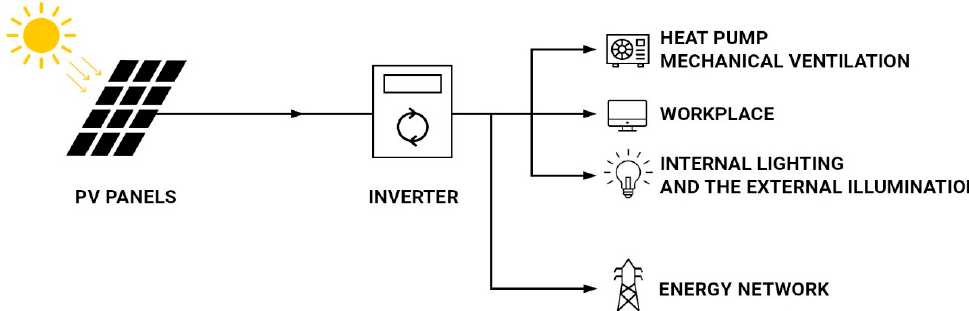
Figure 15. The diagram of power distribution in the analysed building.